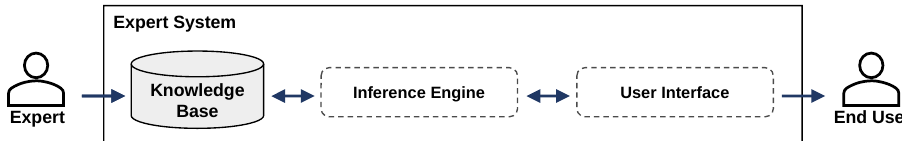
Figure 4. Schematic architecture of an Expert System